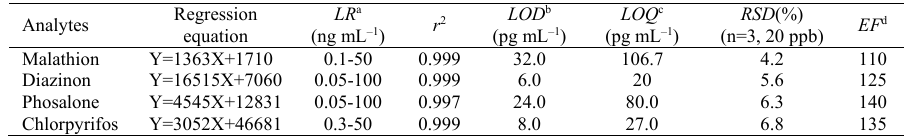
Table 1: Results of regression analysis on calibration curves, linear range, precision, enrichment factors, LOD s and LOQ Regression Analytes equation